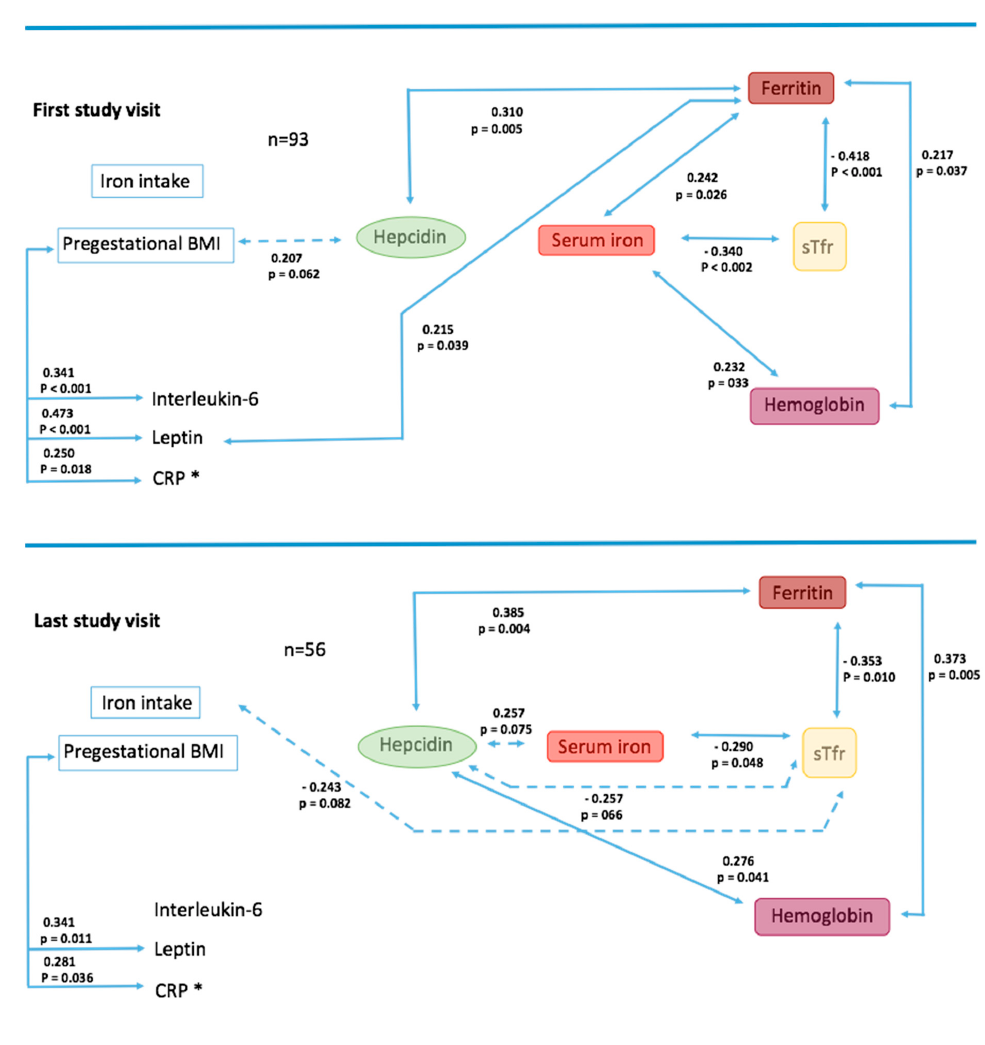
Figure 1. Bivariate associations at first and last study visits. Pearson correlation among all variables (logarithmic transformation was used for variables with free distribution), r values and statistical significance are shown: p values < 0.05 ( ) and < 0.1 ( ); * CRP was significantly associated to: First study visit: IL-6 (0.320, p = 0.002) and to leptin (0.320, p = 0.002); Last study visit: IL-6 (0.400, p = 0.003) and to leptin (0.356, p = 0.008). Regarding the relationship between obesity and the inflammatory and iron markers, pgBMI was positively associated to IL-6, leptin, and CRP. Other than this marginal association to hepcidin, pgBMI did not correlate with any other iron biomarker. None of the measured cytokines were associated to hepcidin, although leptin was positively associated to ferritin.